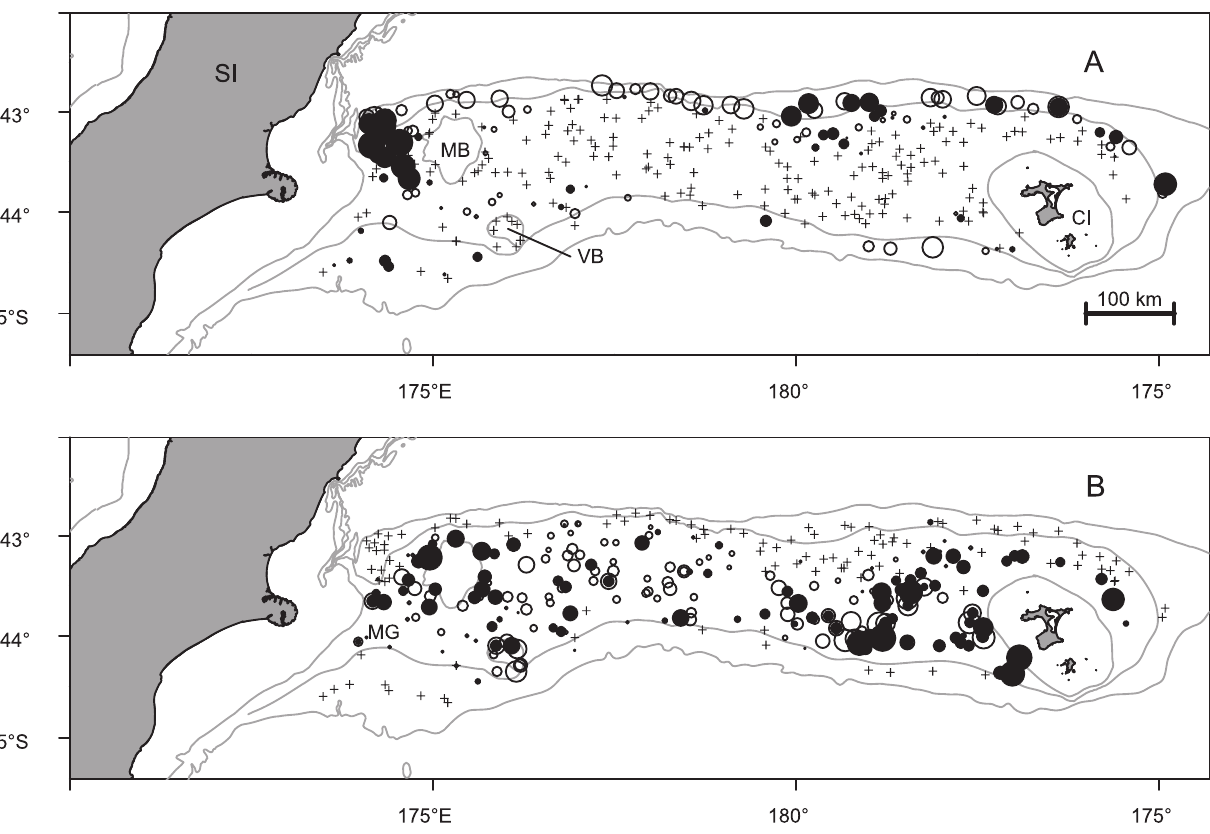
Figure 1. Locations on Chatham Rise of the research trawl tows (crosses), and tows where a) Deaniacalcea , and b) Squalusacanthias were caught (open circles) and non-empty stomach samples were obtained (filled circles). Circle sizes are proportional to catch (max. 189 kg for D. calcea and 264 kg for S. acanthias ) and stomach sample size (max. 51 for D. calcea and 49 for S. acanthias ). Grey lines show the 200 m, 600 m, and 1000 m isobaths; SI, South Island of New Zealand; CI, Chatham Islands; MG, Mernoo Gap; MB, Mernoo Bank; VB, Veryan Bank.